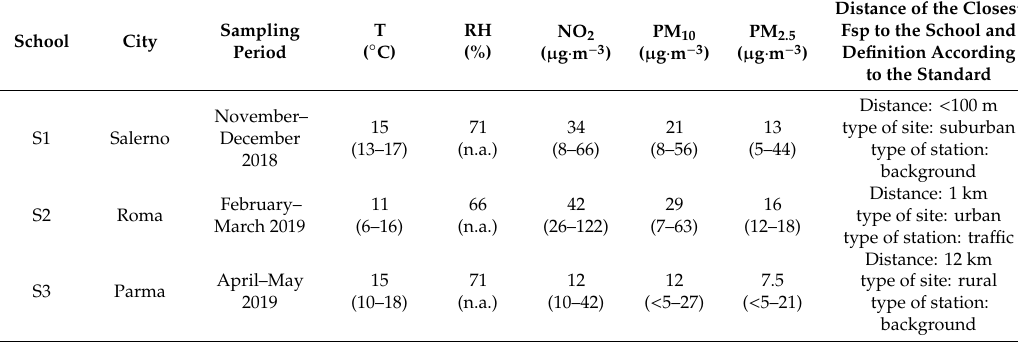
Table 1. School sites, sampling periods and summary of the meteo-climatic conditions (temperature, T, relative humidity, RH) and air quality parameters (NO 2 , PM 10 and PM 2.5 ) measured by the closest fixed sampling stations of the Italian environmental protection agency. The data related to every single period of the campaign are expressed as daily average values and their ranges